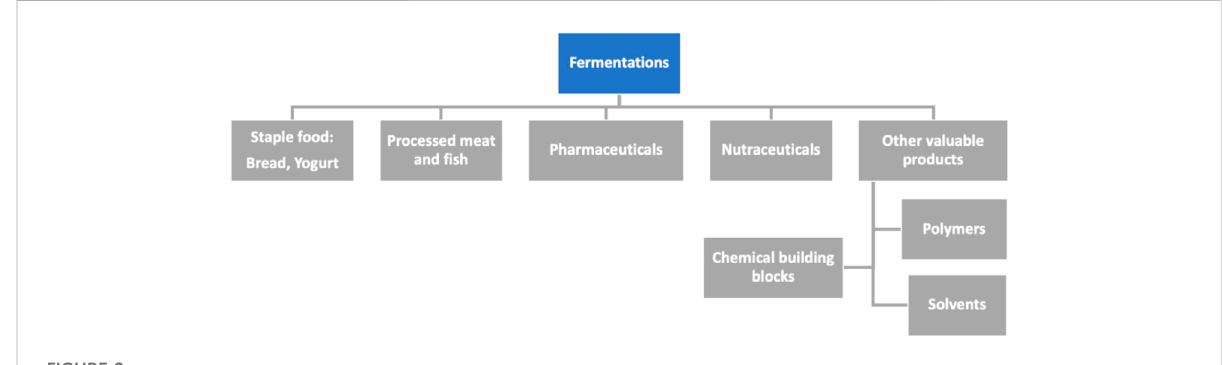
FIGURE 2 Schematic representation of the main areas (in gray) in which fermentation processes (in blue) are traditionally